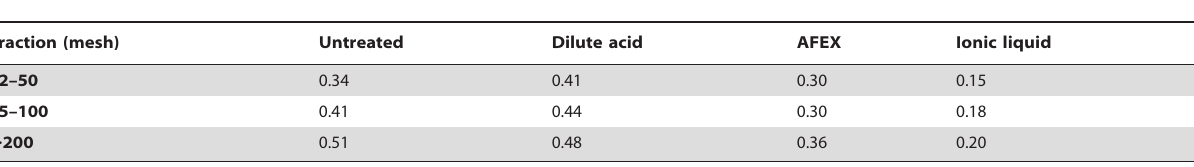
Table 2. Crystallinity index derived from XRD